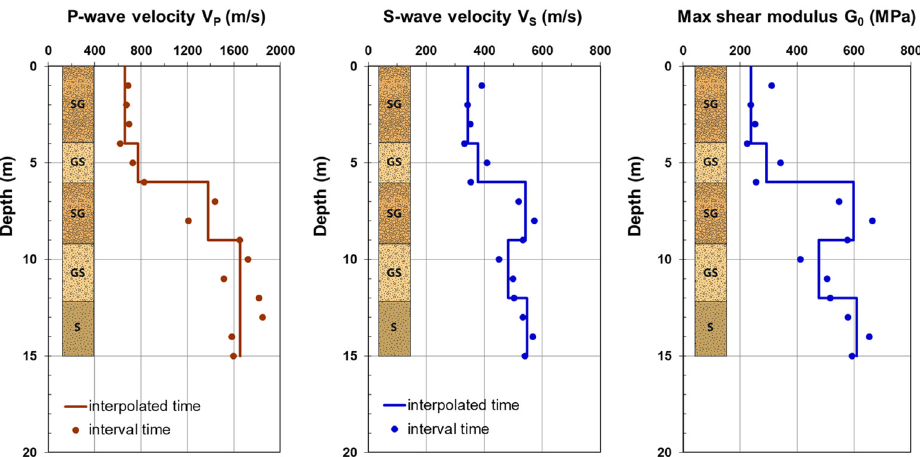
Figure 11. P-wave and S-wave velocities obtained from down-hole test (borehole BH2); SG: sandy gravel; GS: gravel and sand; S: sand.